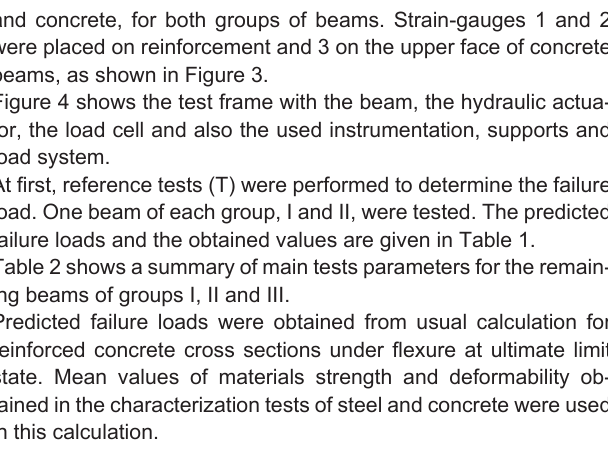
Figure 6 – Strains of concrete and flexural tensile reinforcement: beam VR-NA-CE-02